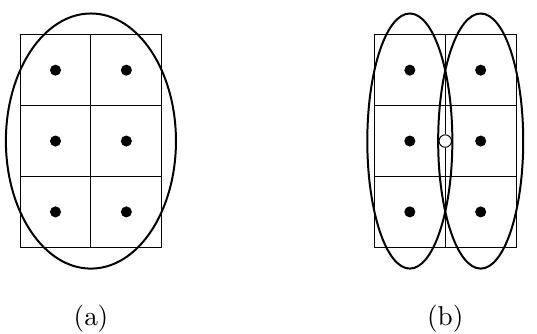
Figure 17 . (a) A 6-local interaction in a HQECC where the cells composing the boundary surfaces are square. (b) The 6-local interaction is simulated by two 4-local interactions, by introducing an ancilla qudit (denoted by the white vertex) which is placed on an edge separating the sets of qudits it is interacting